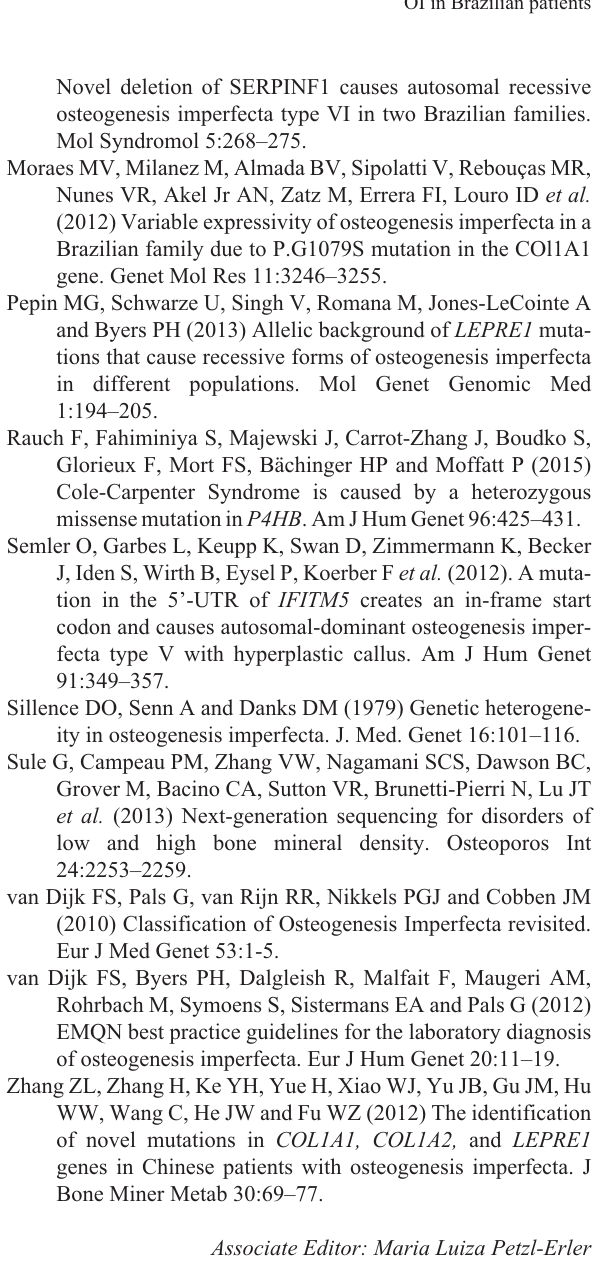
Table S1 - Primers used for COL1A2 gene. Table S2 - Primers used for SERPINH1 gene. Table S3 - Primers used for SERPINF1 gene. Table S4 - Primers used for FKBP10 gene. Table S5 - Primers used for WNT1 gene. Table S6 - Primers used for IFITM5